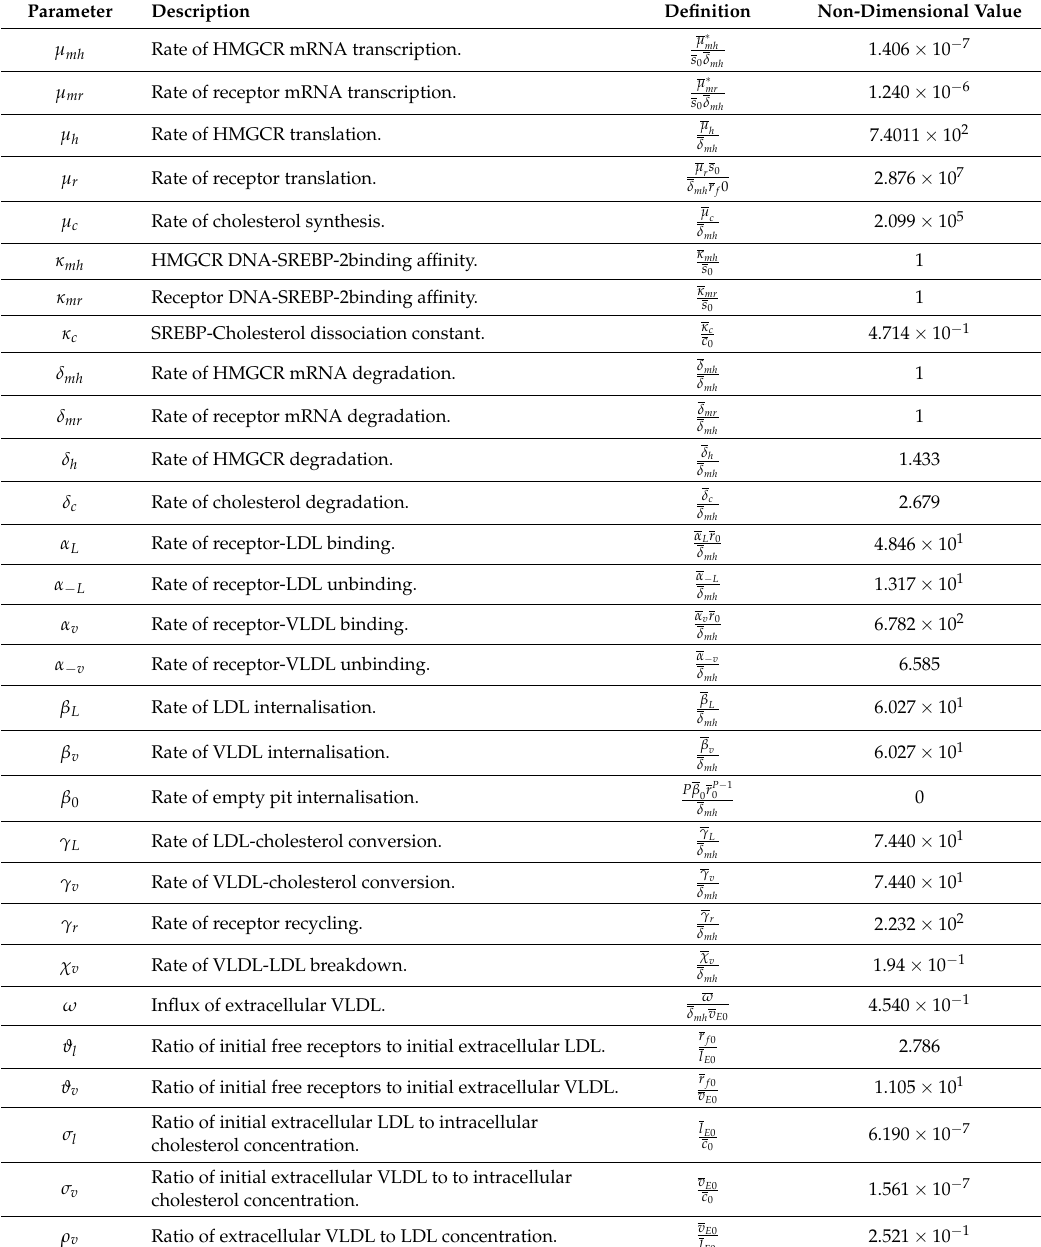
Table 2. Table of non-dimensional parameters including their definition and